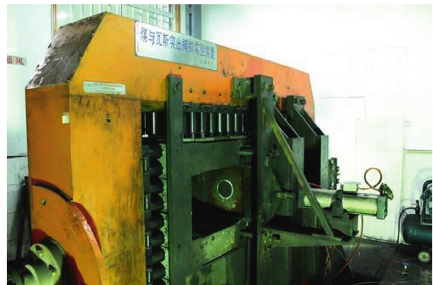
Figure 1: Picture of coal and gas outburst simulation system.